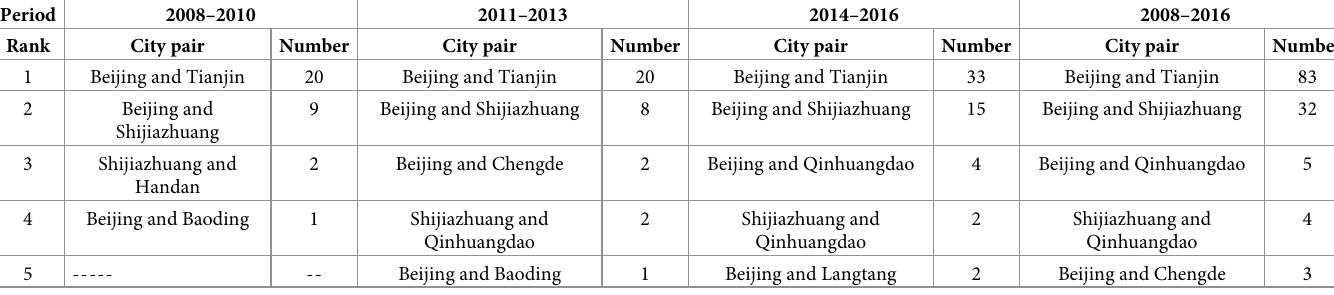
Table 12. Top 5 cities, cross-city cooperation, based on common patent data of the Beijing-Tianjin-Hebei Urban agglomeration, 2008–2016. Period